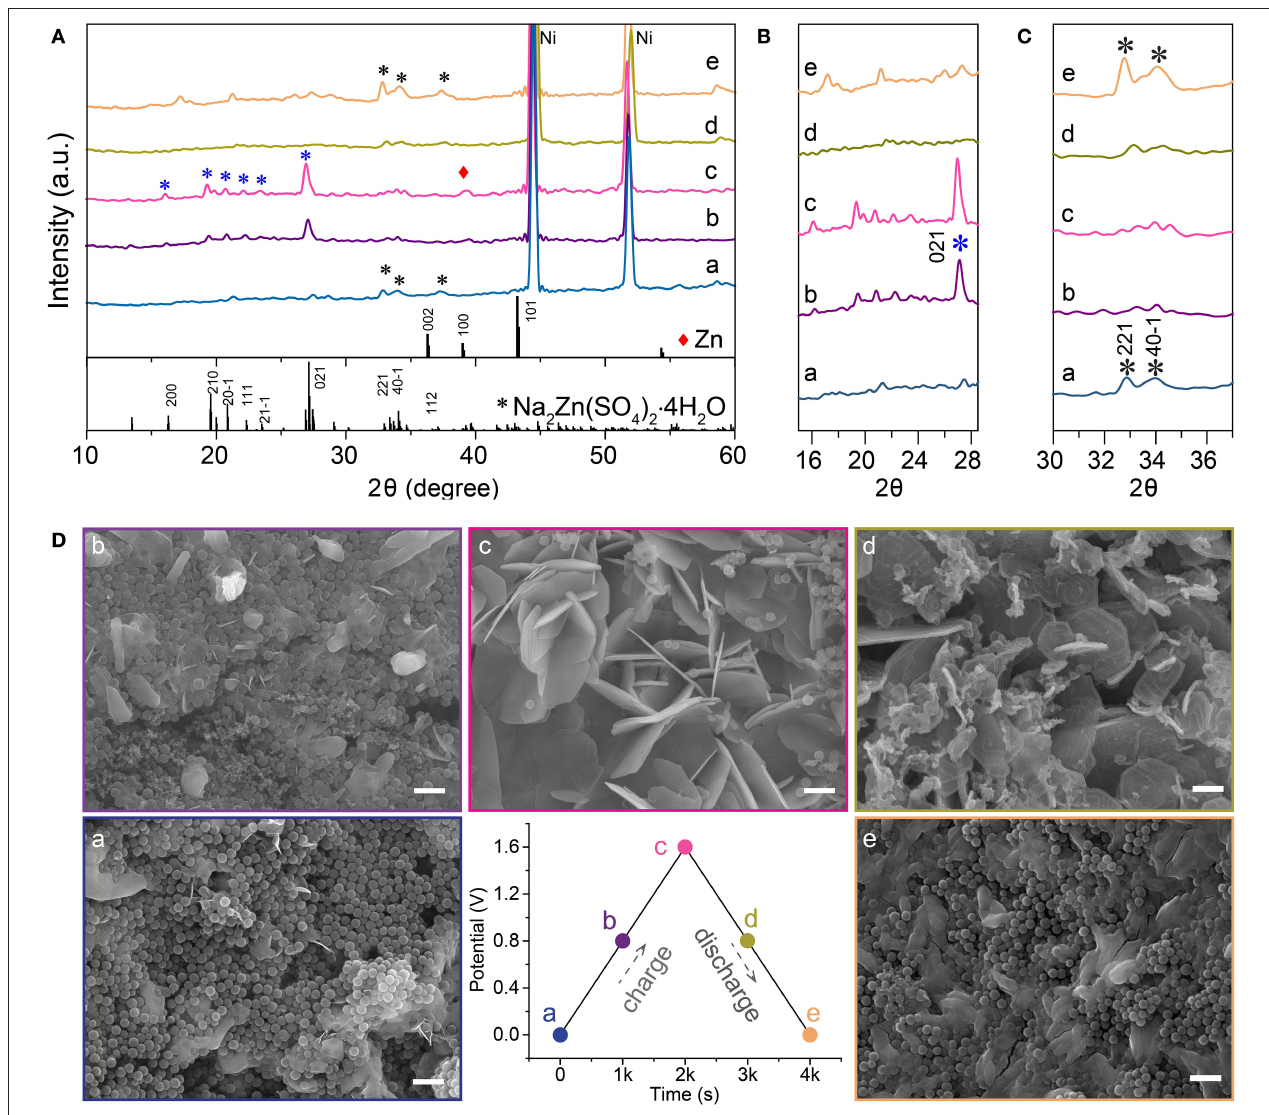
FIGURE 4 | Charge storage mechanism study of zinc-ion hybrid supercapacitors. (A–C) XRD spectra of the anode materials at different charge-discharge states. (D) SEM images of the anode materials at different charge/discharge states, the scale bars are 1 µ m. The star is highligh of the diffraction pattern of Na2Zn(SO4)2 4H2O.